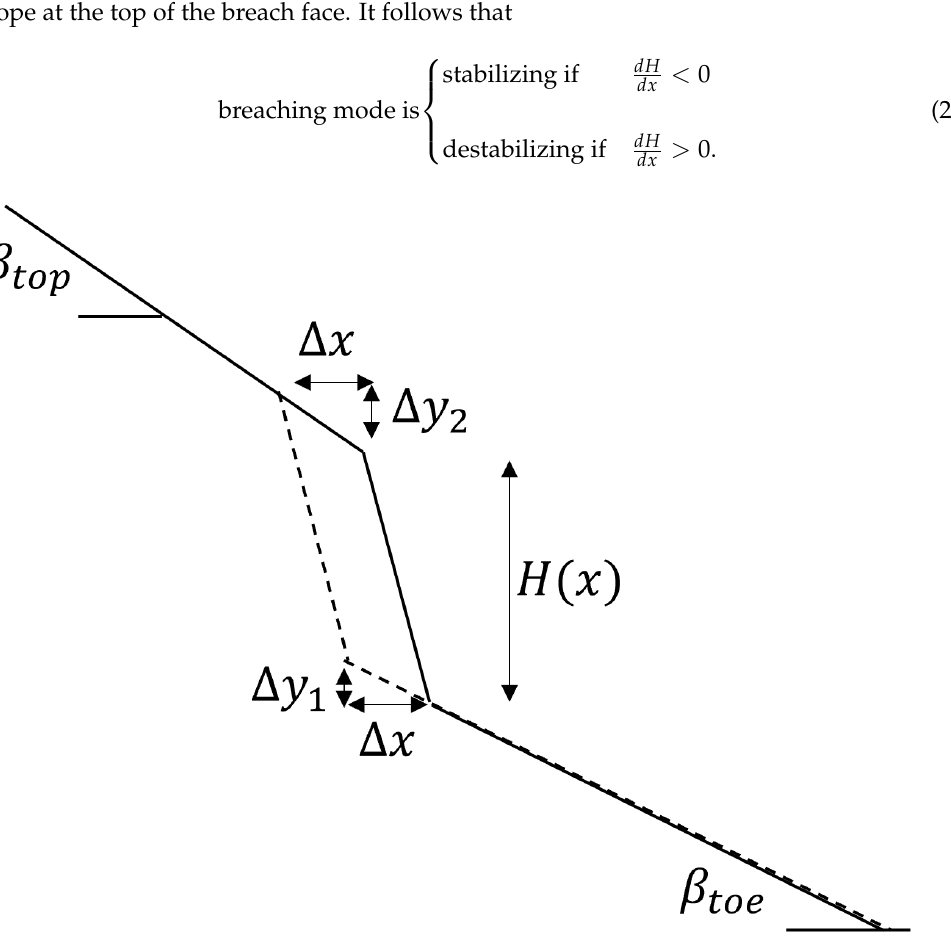
Figure 2. Schematic overview of a 2D breaching failure. During a time interval ∆ t the breach face moves over a distance ∆ x and the slope at the toe progresses by sedimentation over the same distance. It is assumed that during this interval the angles β top and β toe remain